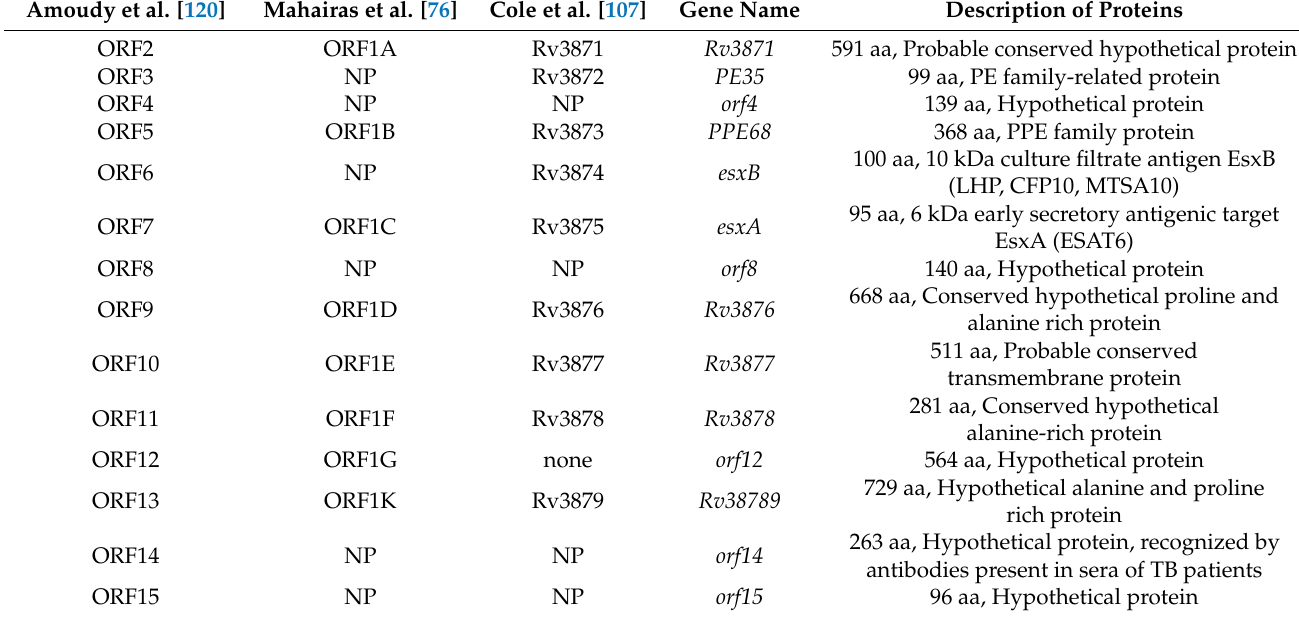
Table 2. Gene annotation, gene name, and description of proteins encoded by genes in